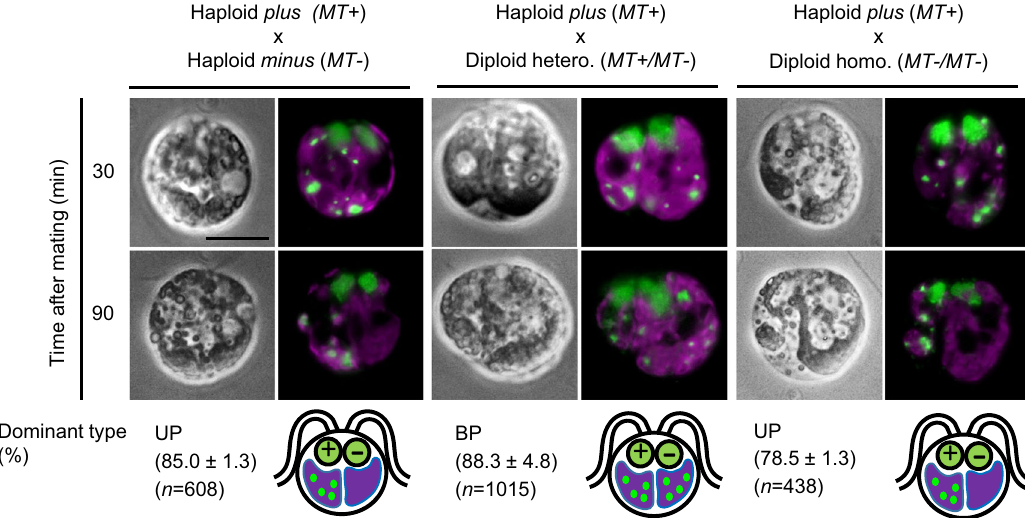
Fig. 1 Chloroplast DNA from gametes harboring MT + is protected from degradation in zygotes. Differential interference contrast and overlaid fl uorescent images of early-stage zygotes were taken at 30 and 90 min after mating. Cells were stained with SybrG (green) for visualizing cpDNA, organized into nucleoids via punctate staining within chlorophyll auto fl uorescence (magenta), and nuclear DNA within two nuclei (see below diagrams for their locations). Complete cpDNA degradation is indicated by no green signals within one chloroplast. Bar = 5 μ m. The below diagrams illustrate the early- stage zygote cells with two nuclei (green) and two chloroplasts (violet) with nucleoids (green dots). The percentage of the dominant cpDNA degradation pattern for each mating combination was calculated from three biological replicates (mean ± s.d.) “ n ” indicates the total number of zygotes